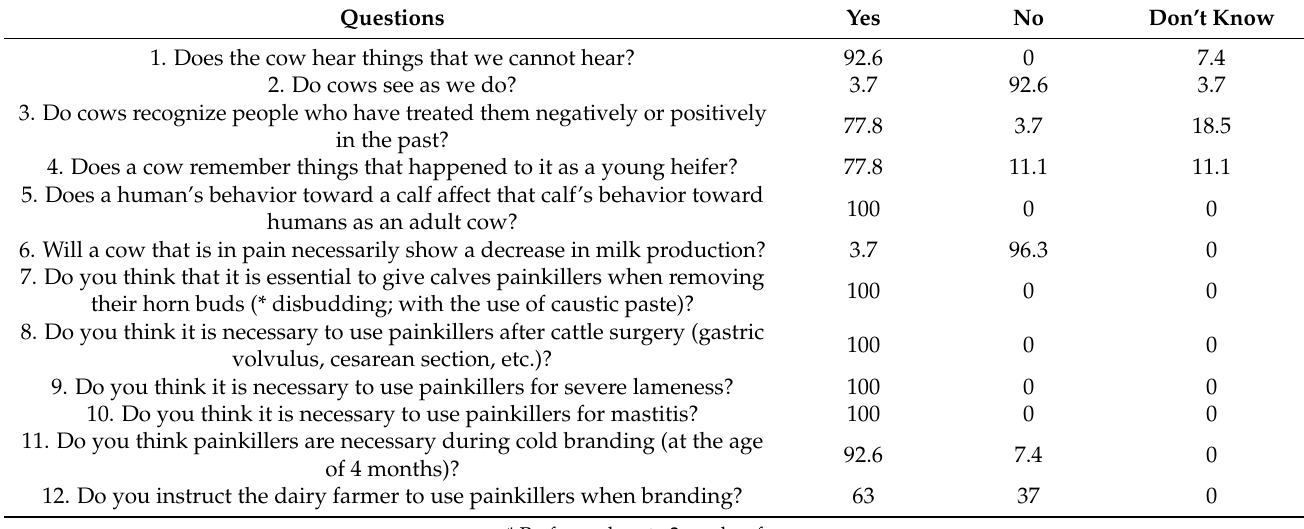
Table 1. Distribution (in percentages) of veterinary practitioners’ answers to questions regarding senses, memory, and pain perception ( n =